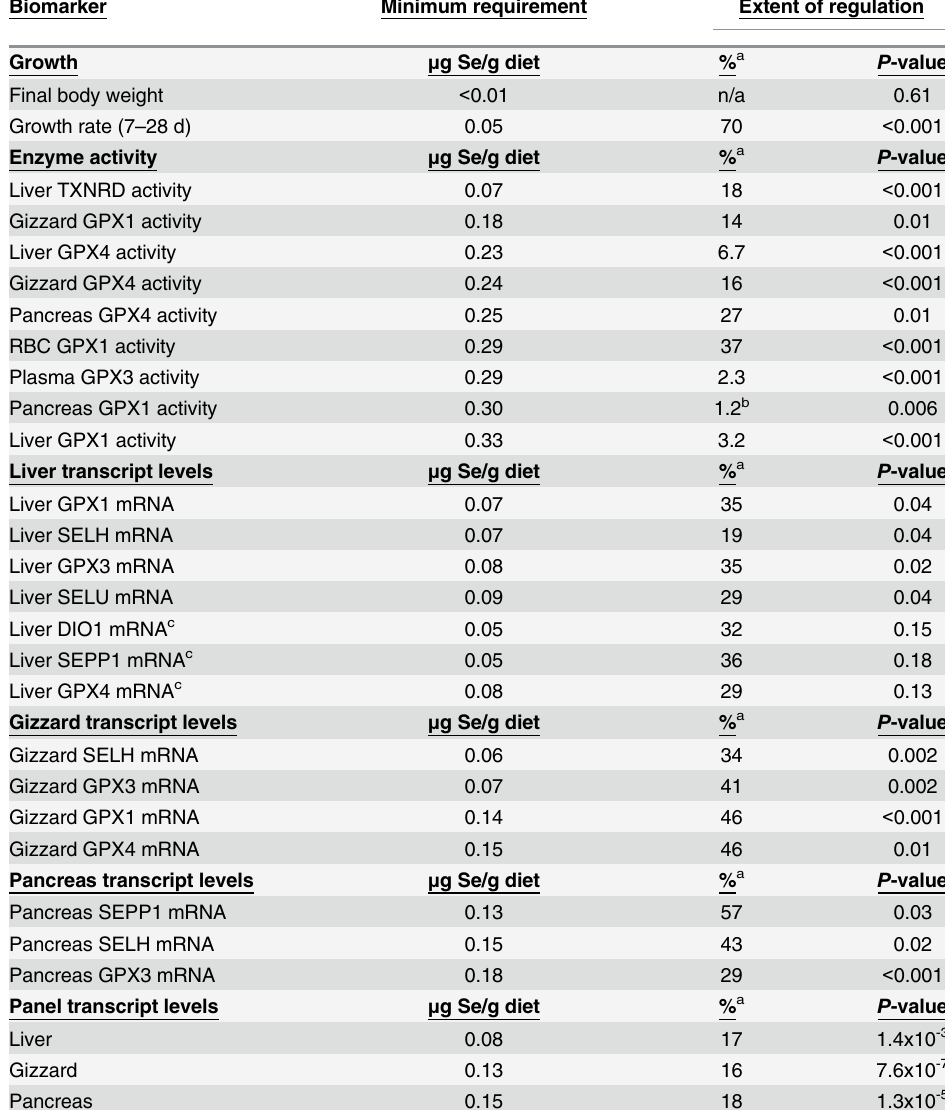
Table 2. Se requirement hierarchy in turkey